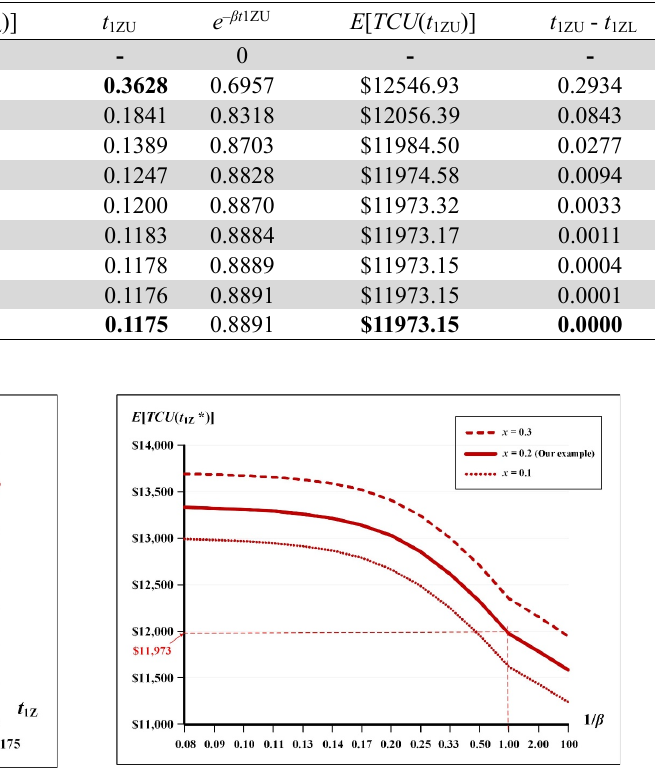
Fig. 7. The convexity and behavior of E [ TCU ( t 1Z )] relating Fig. 8. The combined effect of changes in 1/ β and x on E [ TCU ( t 1Z *)] to t 1Z